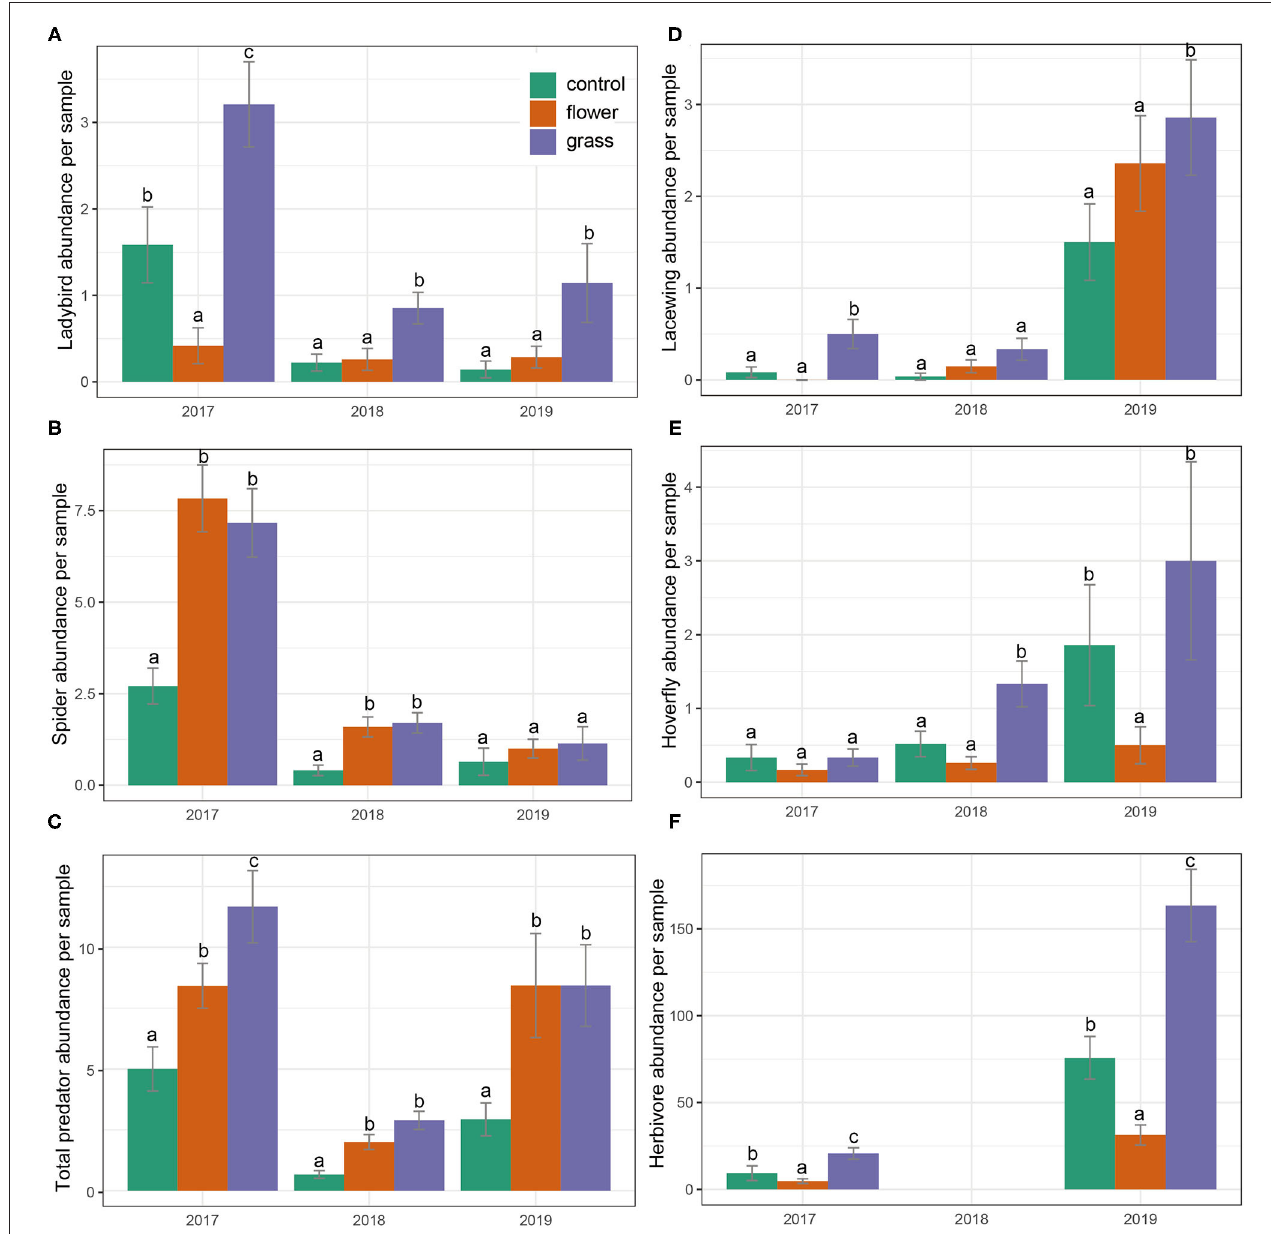
FIGURE 3 | (A-F) Predator and herbivore abundances (mean ± SE) in the cover crops during the 3 years (2017–2019). Within each year, bars capped with the different letter are significantly different ( P <